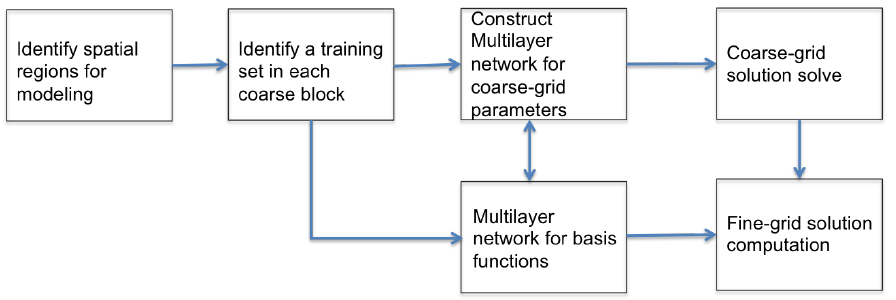
Figure 2. A flow chart in illustrating the idea of using deep learning in the generalized multiscale finite element method (GMsFEM)